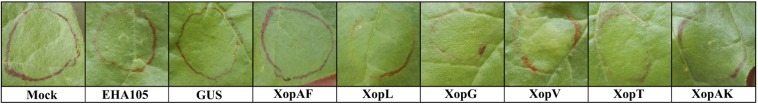
Visual observation of controls and tested-strains of the second dataset at 3 dpi. Mock-inoculated (Mock), A. tumefaciens strain no protein expressed (EHA105), the transient expression of β-glucuronidase protein (GUS) were considered as the three controls on each leaf. The six transient expression of T3E genes were considered as the tested-strains (transient expression of xopAF: AF, xopL: L, xopG: G, xopV: V, xopT: T, xopAK: AK, respectively). Constructs for transient expression are described in Supplementary Table 1.